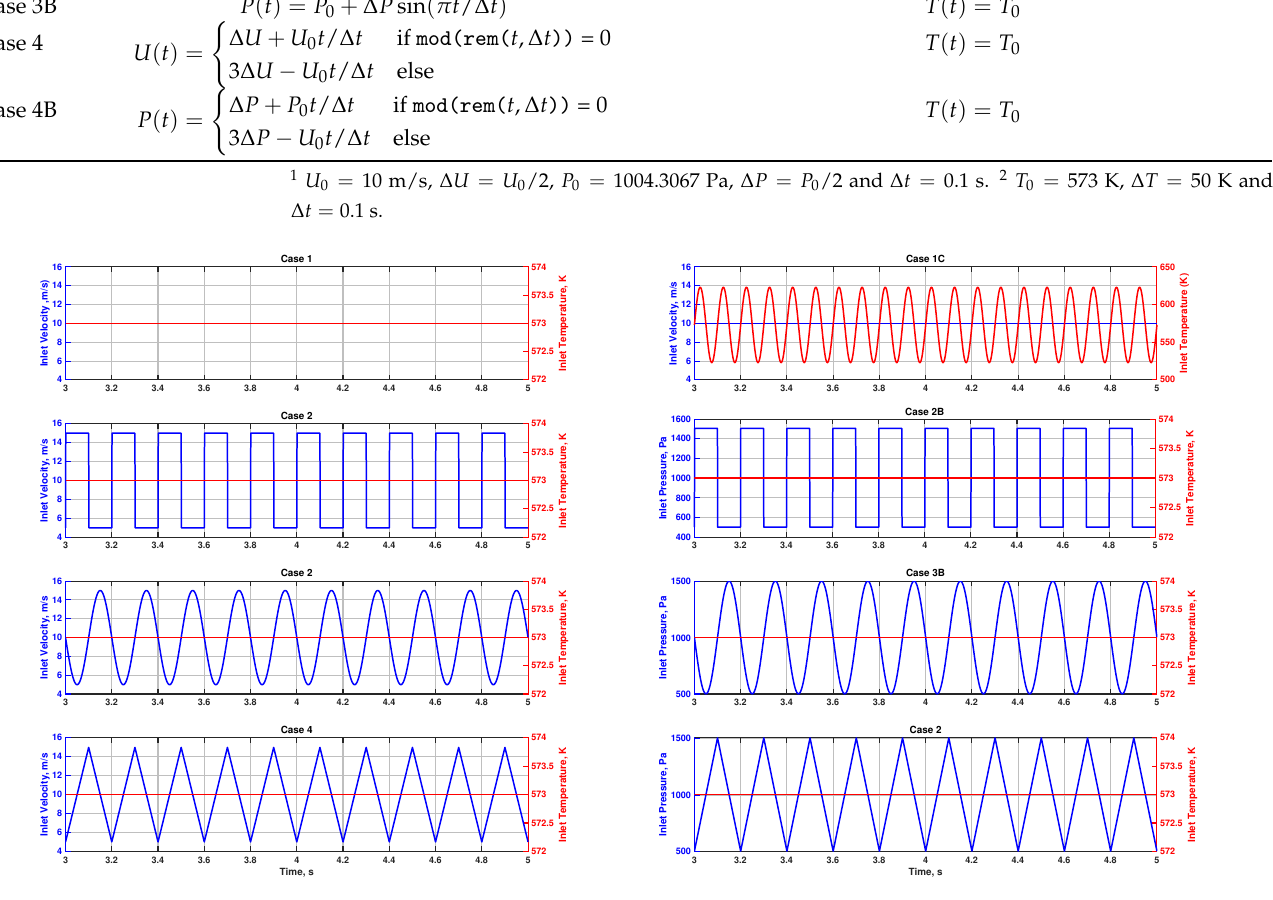
Figure 2. Inlet velocities and temperatures over time as obtained in cases 1, 2, 3 and 4. The blue lines and the red lines represent velocity and temperature